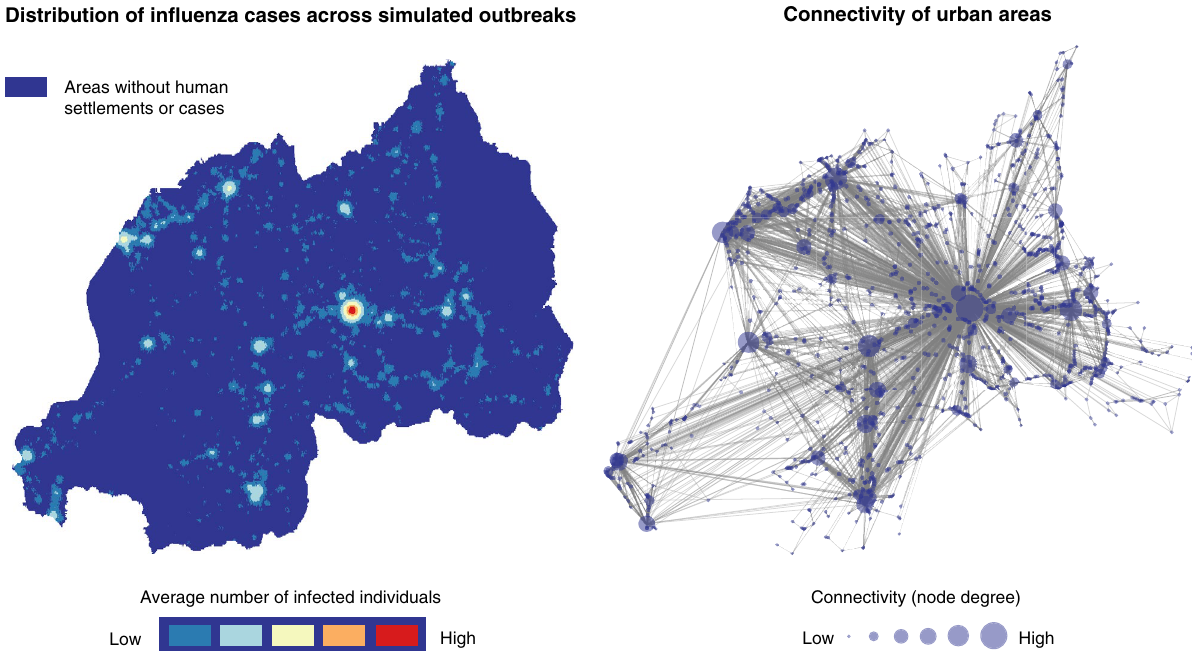
Figure 5. Left: Heat map of the average influenza cases over the course of simulated outbreaks in Rwanda. Right: Map showing connectivity of urban areas in the